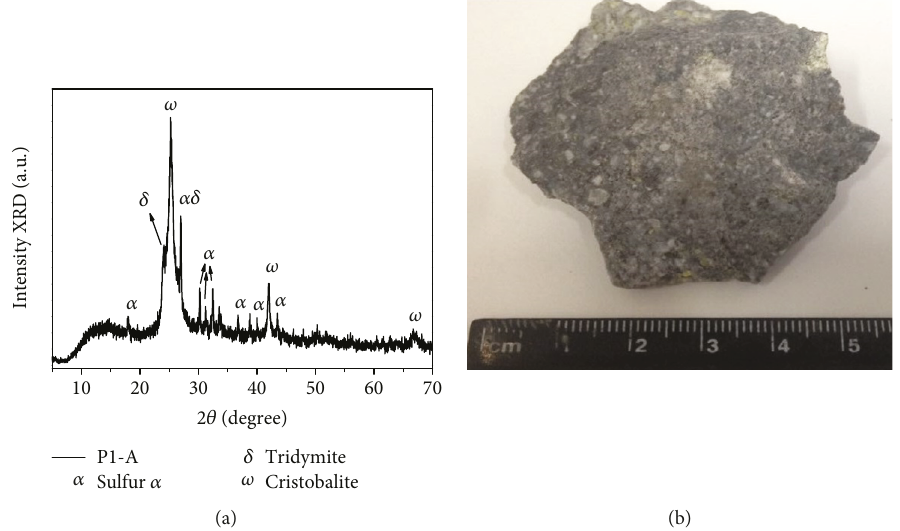
Figure 9: Sample P1-A (a) XRD patterns and (b) rock sample of crystalline tu ff .